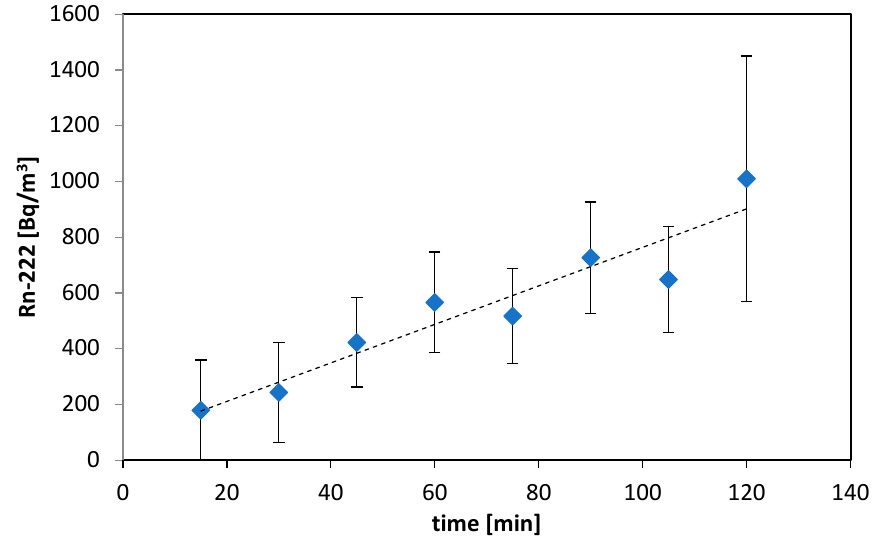
Figure 6. Ingrowth of radon concentration under accumulation chamber.